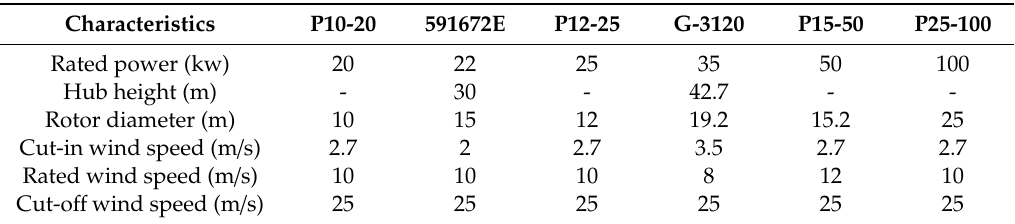
Table 4. The technical data of wind